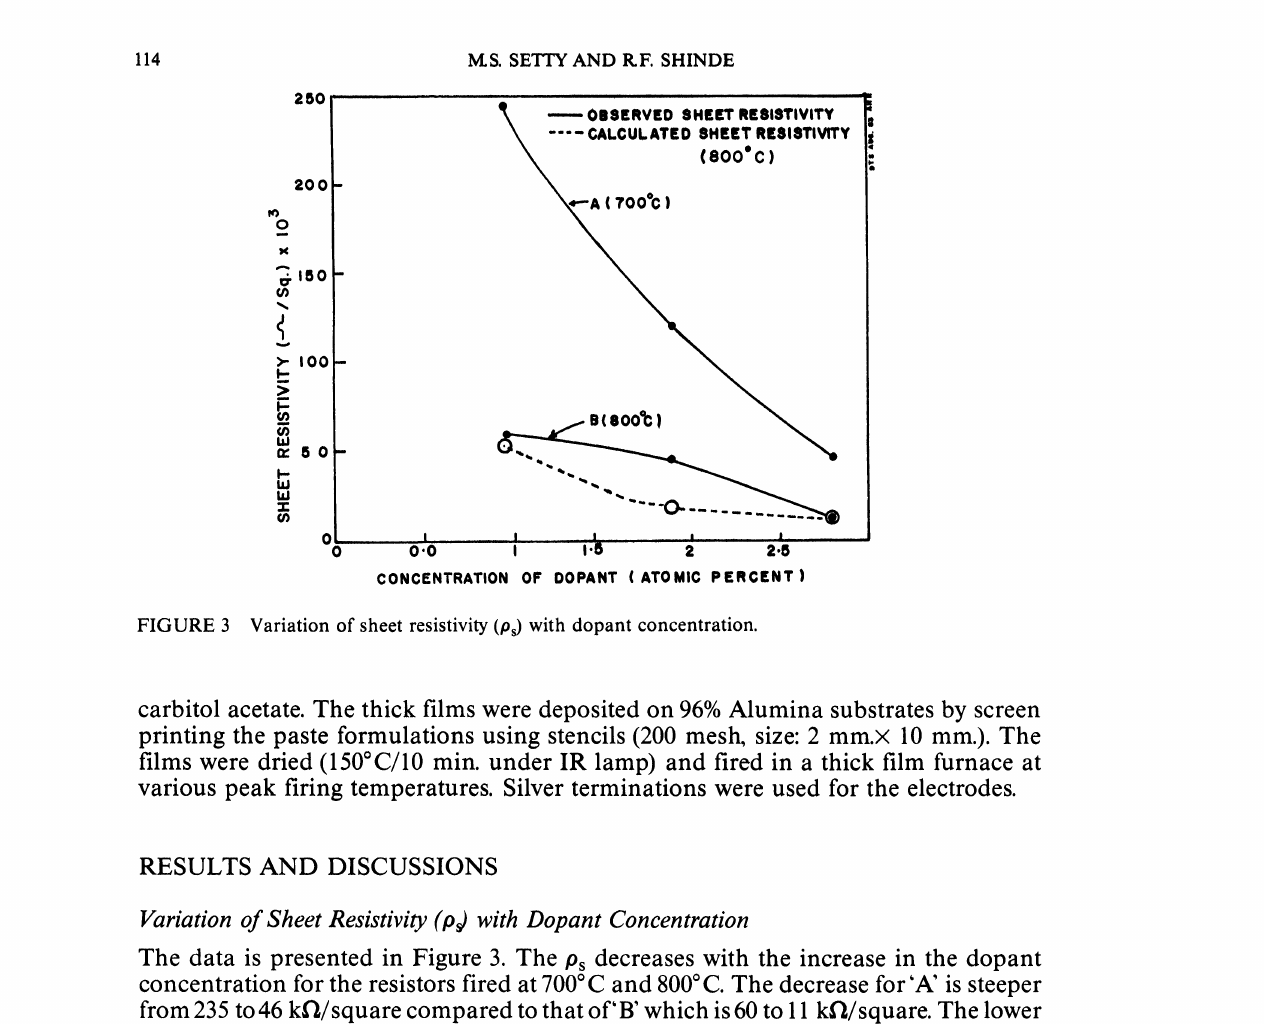
FIGURE 3 Variation of sheet resistivity (Ps) with dopant